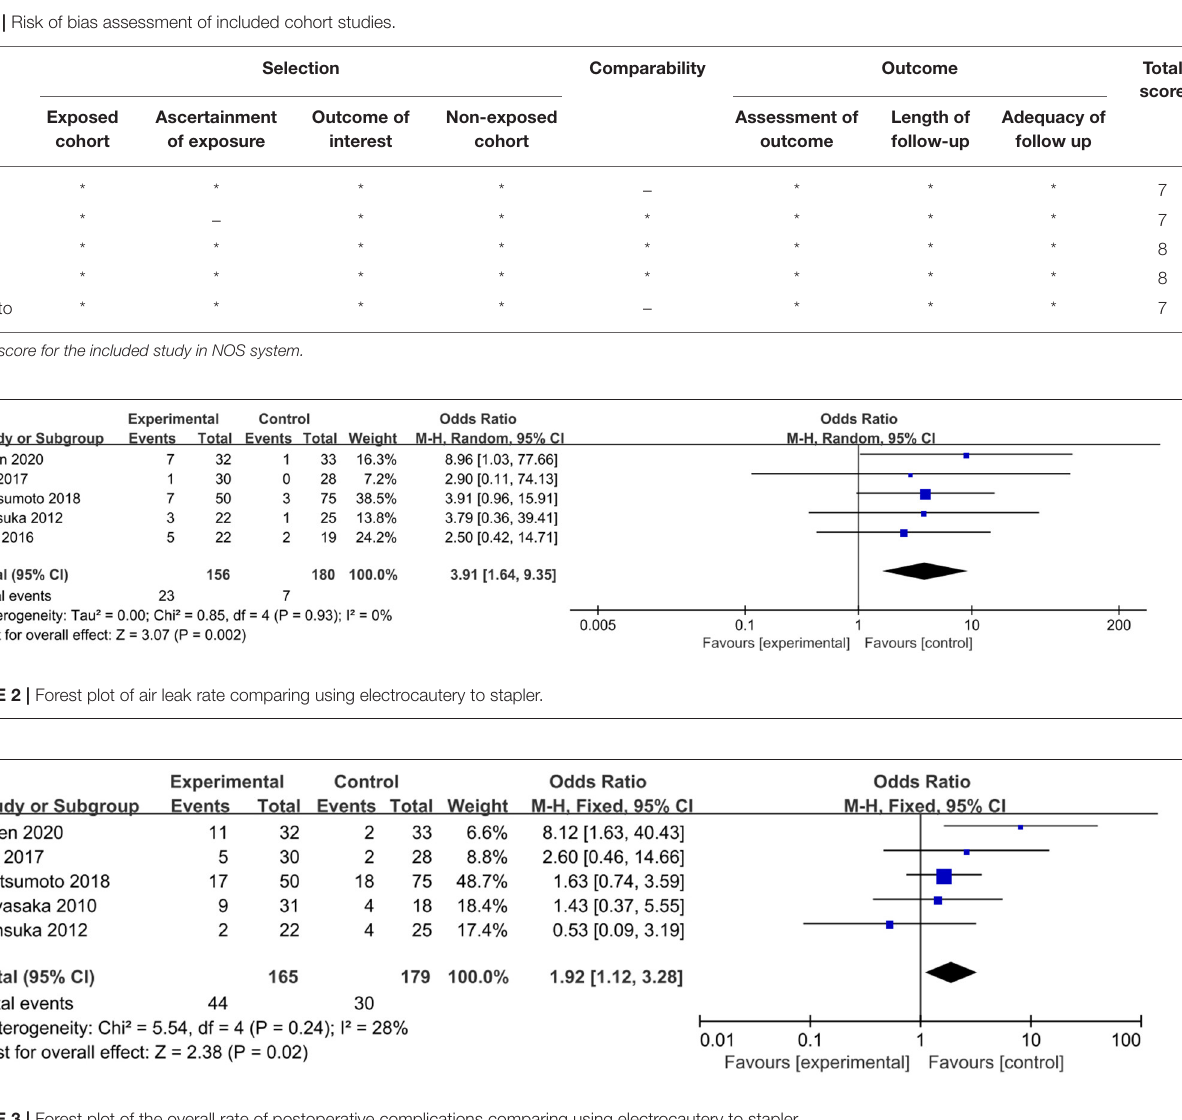
FIGURE 3 | Forest plot of the overall rate of postoperative complications comparing using electrocautery to stapler.